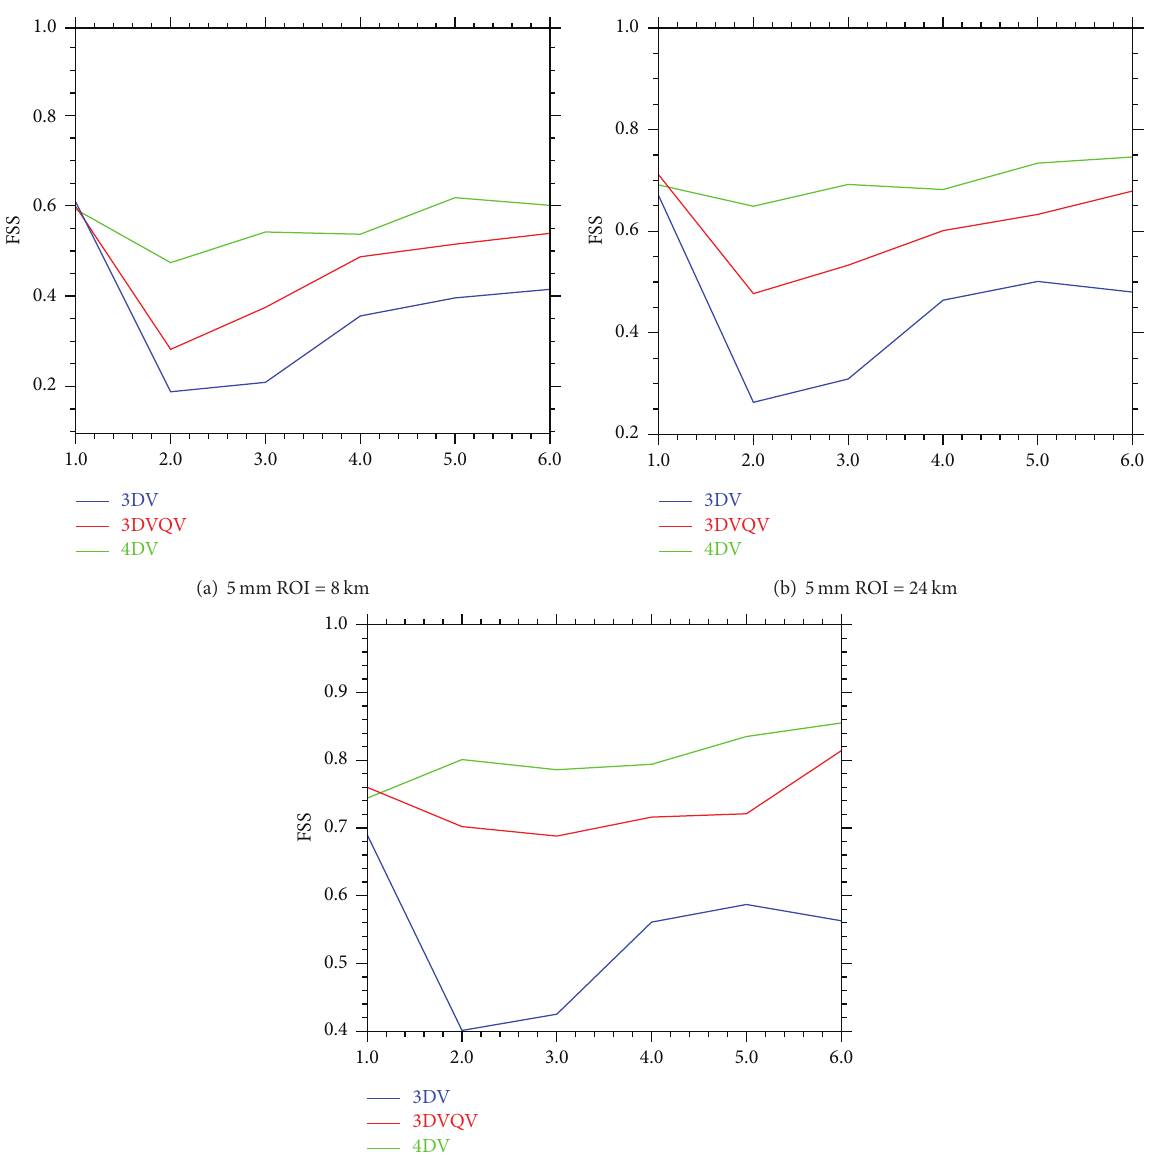
with the existing scheme using 𝜓 and 𝜒 momentum